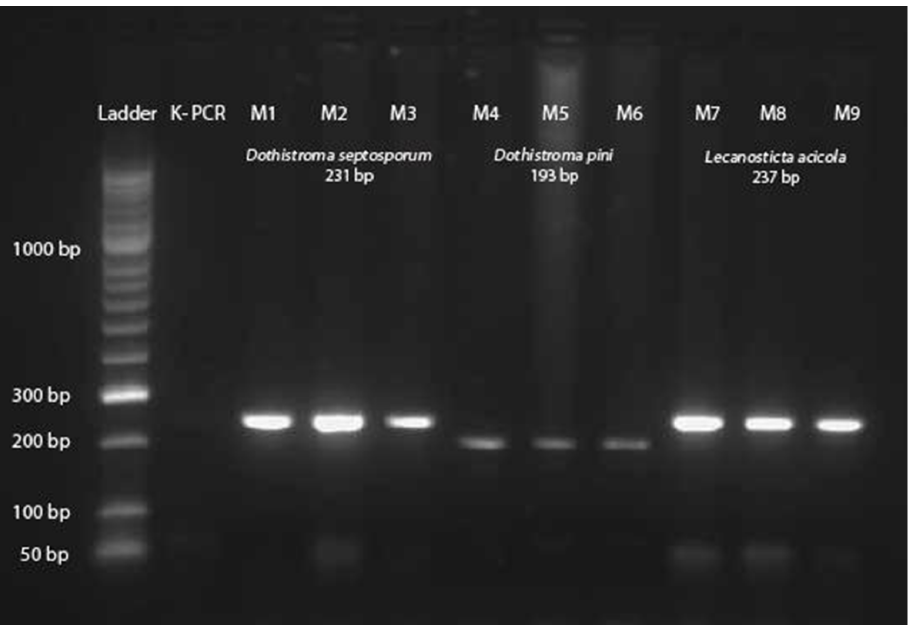
Figure 1. Polymerase chain reaction products using specific primers to detect Lecanosticta acicola (LAtef.F, LAtef.R), Dothistroma septosporum (DStub2-F, DStub2-R), and D. pini (DPtef-F, DPtef-R). The names M1-M9 at the top of the gel refer to sample numbers.